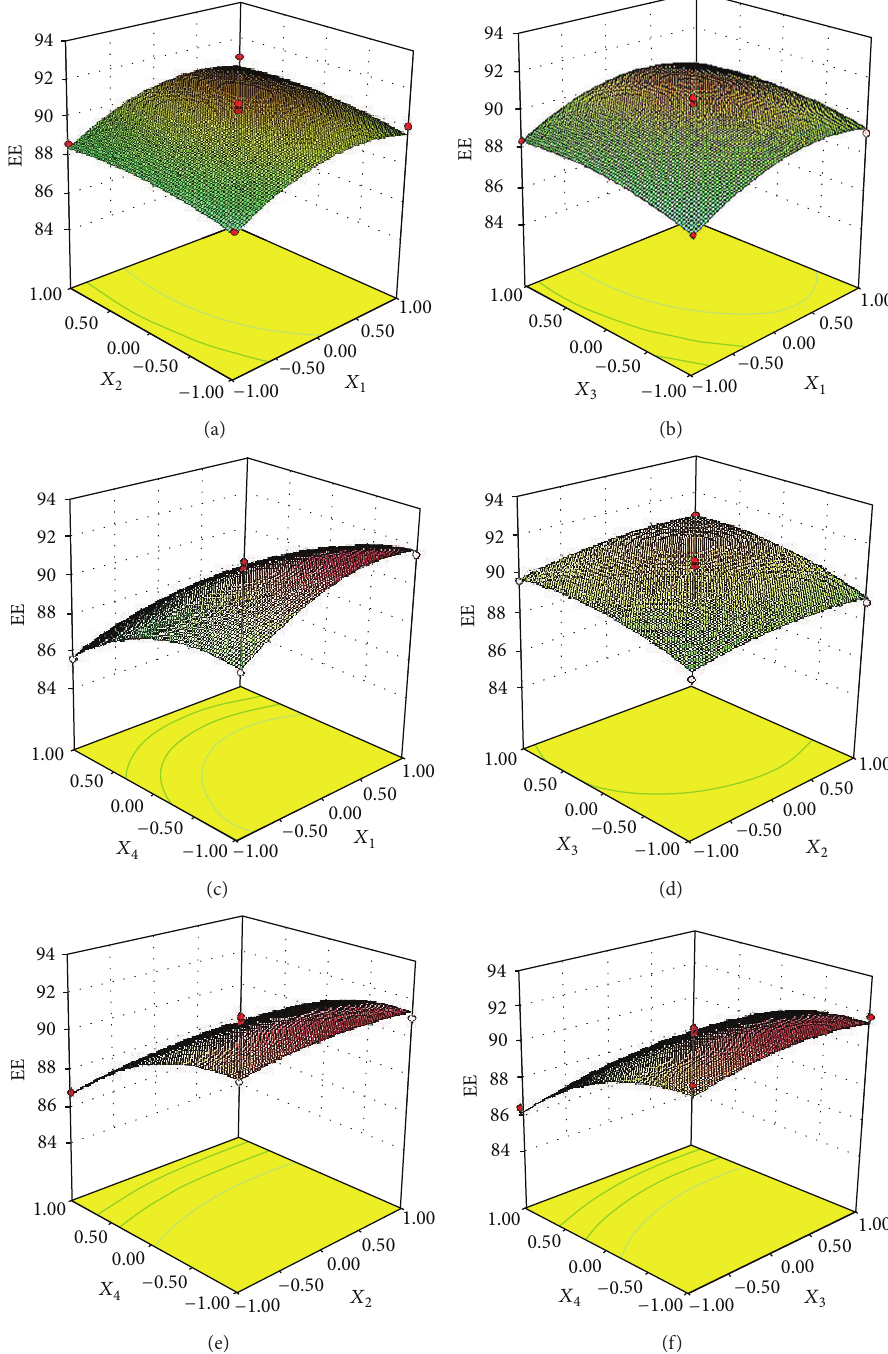
Figure 1: 3D response surface plots for EE with respect to (a) MD: GA versus solid content; (b) MD: GA versus GMS content; (c) MD :GA versus core:coating; (d) solid content versus GMS content; (e) solid content versus core:coating; (f) GMS content versus core: